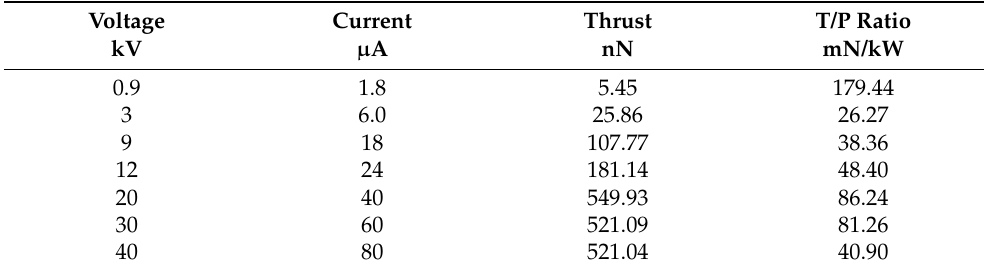
Table 3. Simulation results for the study of the influence of discharge current in the single-stage argon EHD thruster by varying the applied voltage for a fixed ballast resistor of 500 M Ω